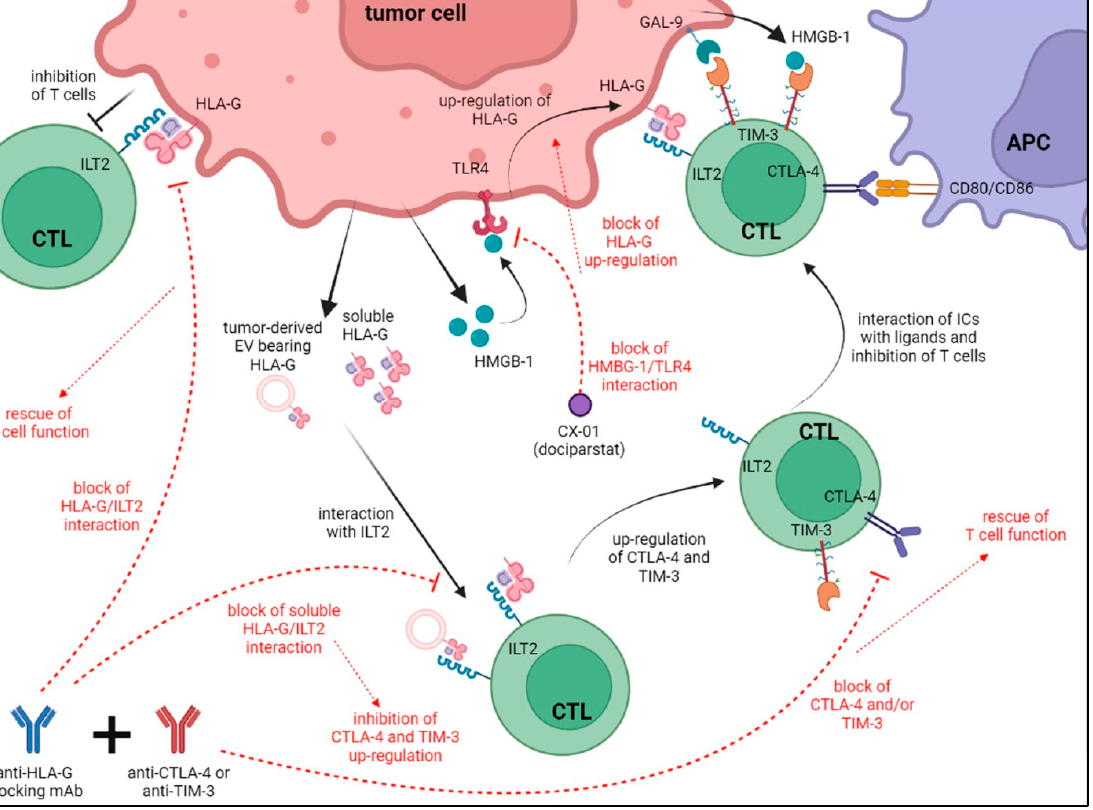
Figure 2. Schematic representation of the interactions of HLA-G with CTLA-4/TIM-3 and their ligands. Possible effects of the administration of anti-CTLA-4 and/or anti-TIM-3 in combination with anti-HLA-G blocking antibodies are also shown.